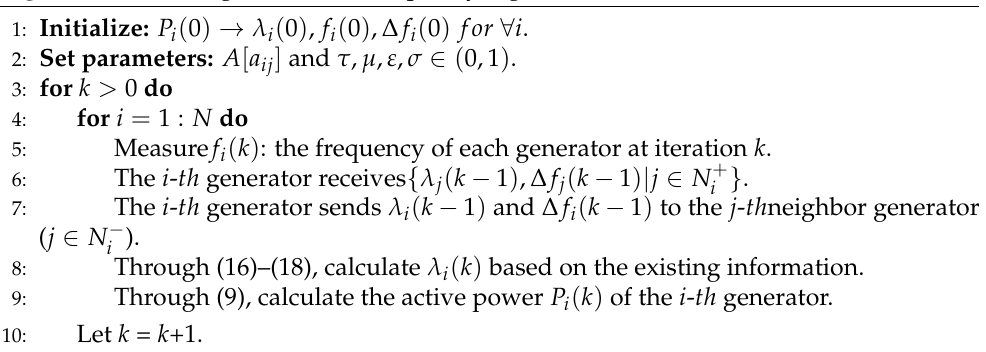
Algorithm 1 DED algotithm with frequency